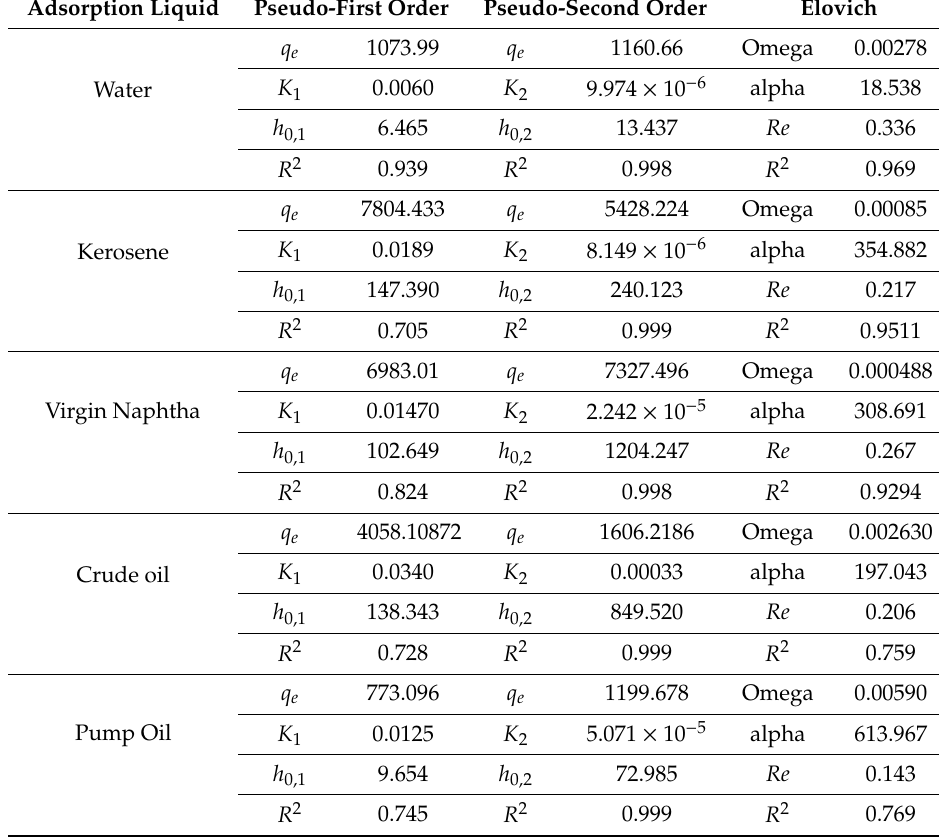
Table 6. The kinetic coe ffi cients of pseudo-first order (PFO), pseudo-second order (PSO) and Elovich models for 0-EGF